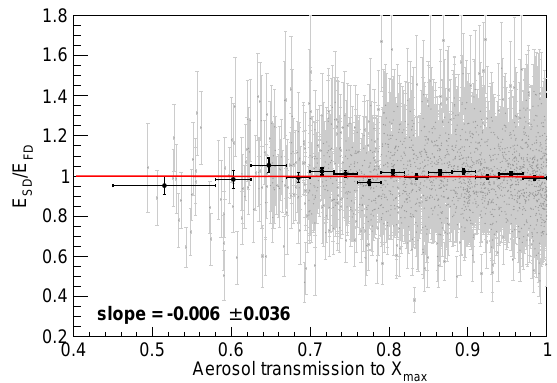
Figure 4. TA energy-dependent reconstruction bias due to the aerosols. Natural logarithm of the ratio of the recon- structed Monte Carlo energy and the thrown (generated) energy, ln( E rec / E thr ) is plotted versus the logarithm of the thrown energy log ( E thr / eV). Red points correspond to the Monte Carlo re- 10 construction using VAOD of 0.04 and the blue points correspond to the reconstruction using VAOD of 0.034. The Monte Carlo events were generated with VAOD of 0.04 in both cases. As the linear fits (solid lines) to the mean values of ln( E rec / E thr ) indi- cate, the bias for the 0.04 VAOD reconstruction (filled circles) is -0.9% per decade, and the bias for the VAOD 0.034 reconstruc- tion (filled squares) is -1.7% per decade of energy.